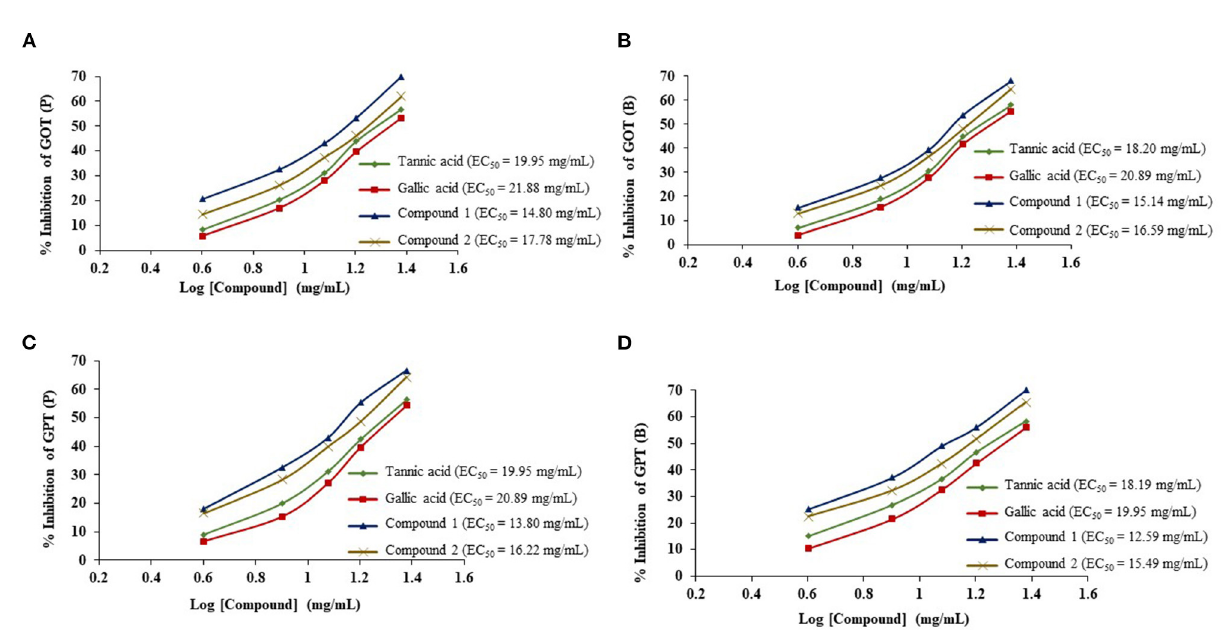
FIGURE3 Inhibition activity (EC 50 ) against ruminal cellulase for compounds 1 and 2 compared with tannic acid and gallic acid. Different letters above the bars indicate significant differences between the treatments.